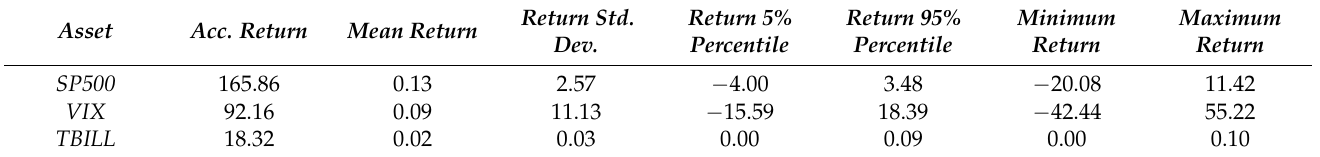
Table 2. Statistical and performance summary of the three portfolio assets (figures in percentage). Asset Acc. Return